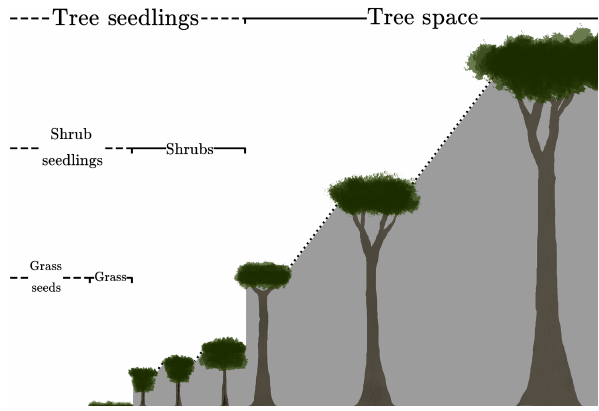
Figure 1. Schematic depicting the hierarchical PFT functional group regime within RED. Trees shade trees, shrubs, and grasses. Shrubs shade shrubs and grasses, while grasses only shade grasses.